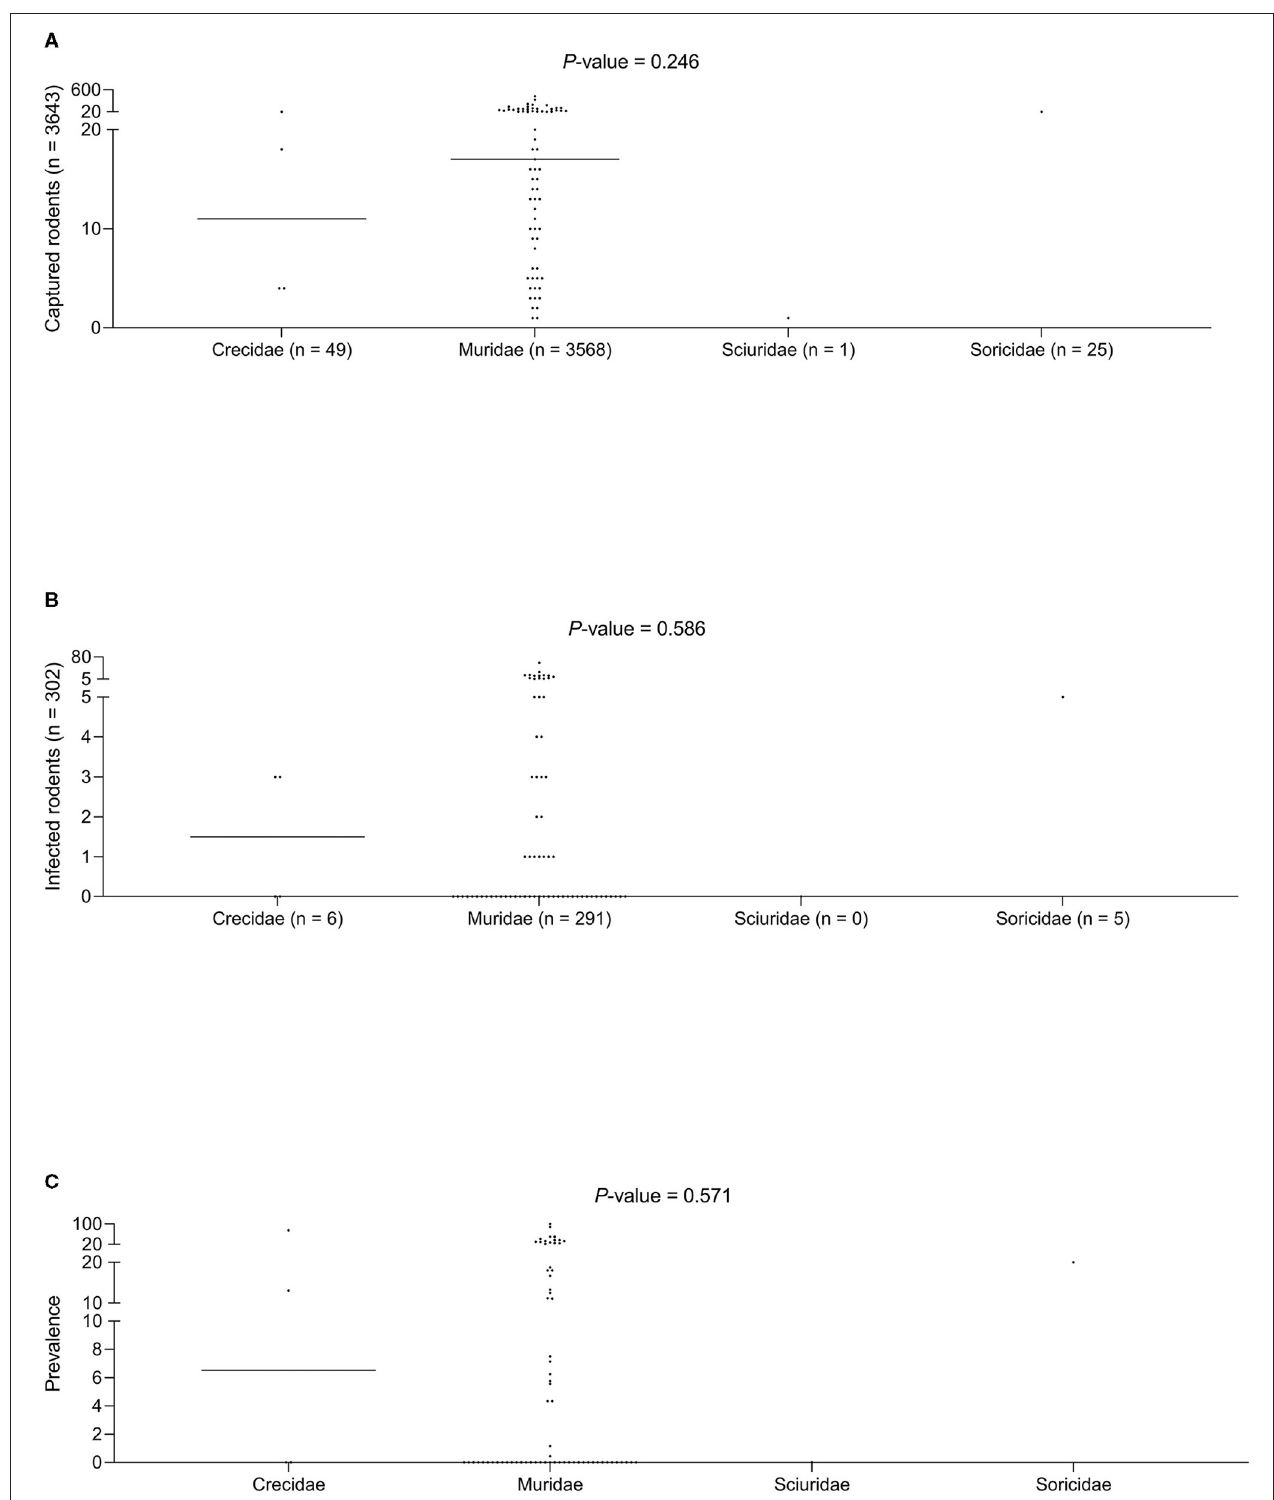
FIGURE 3 | (A) Captured rodents. (B) Infected rodents. (C) Prevalence of infection among different rodent families.